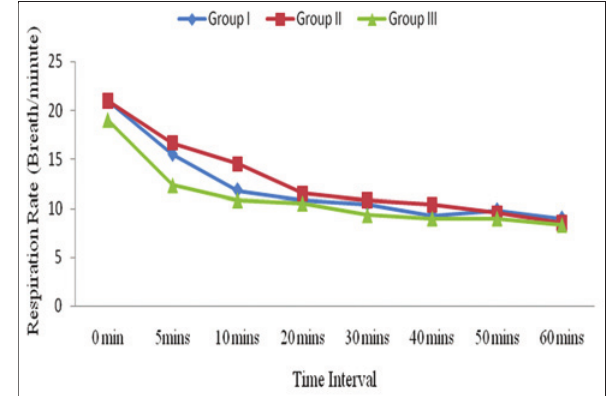
Figure-3: Mean respiratory rate (breaths/min) of birds indifferent